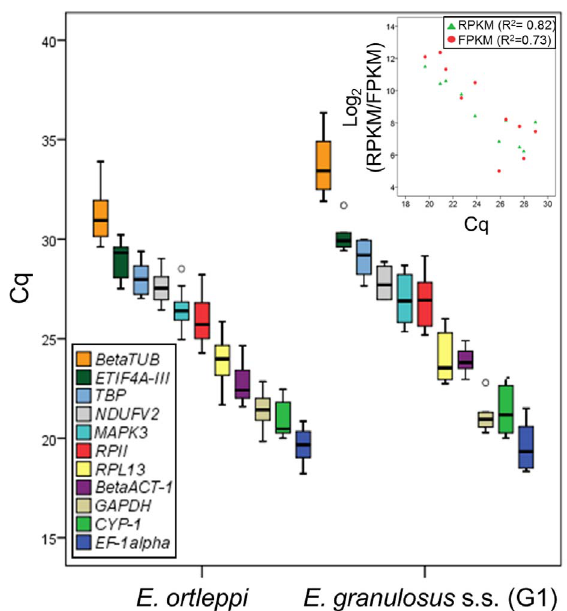
Figure 1. Assessment of transcript abundance and comparison with RNA-seq data. Note the similarity in the boxplot distribution for each gene and the high dispersal values for several genes, such as b TUB and RPII , in both species. The mean Cq value for each gene (including both PS and PSP experimental groups) in E. ortleppi was compared with the published RNA-seq data for E. granulosus spp. protoscolex (FPKM from the Cuffdiff program [9]; RPKM from the ERANGE program [8]) as shown in the top right. Due to a high standard deviation, the b TUB gene was excluded in the qPCR vs. RNA-seq comparison.